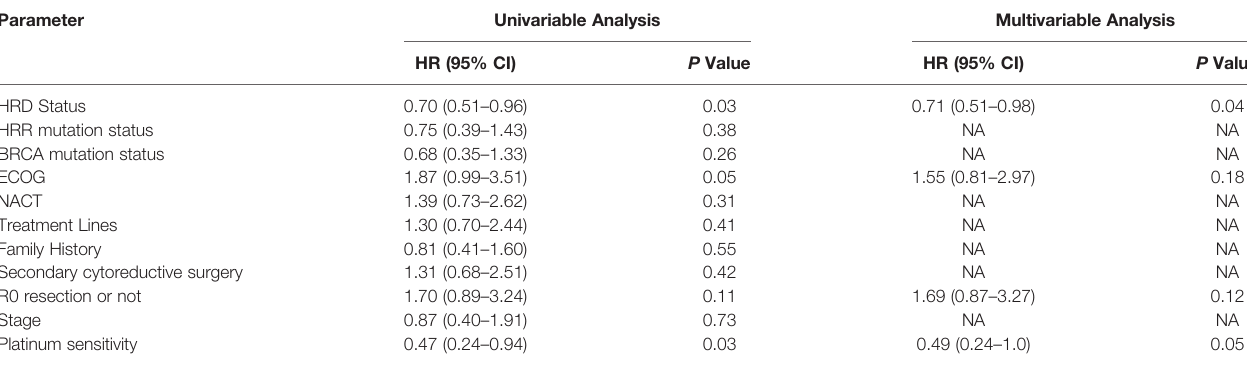
TABLE 3 | Univariable and Multivariable Analysis of Progression-Free Survival for the platinum sensitivity status evaluable subgroup (N = 49).